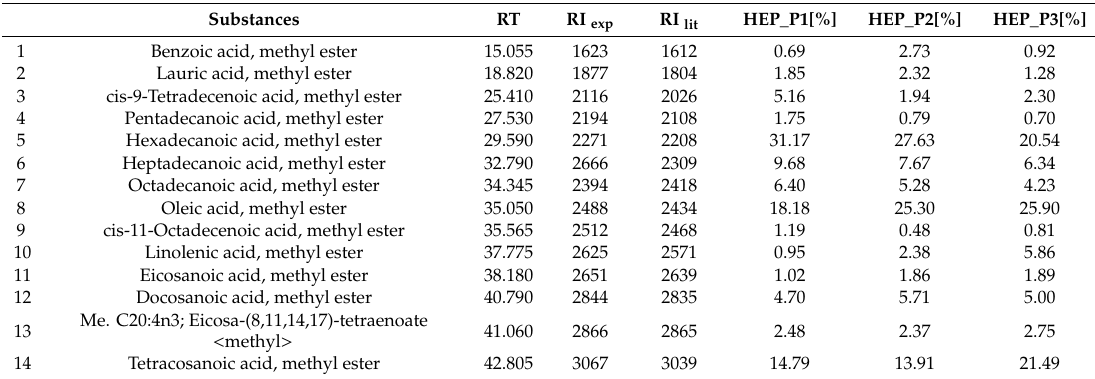
Table A4. Percentage of fatty acids in hexane extracts of propolis (HEP) from di ff erent regions of Poland: HEP_P1 —Podlasie (Hajnowka), HEP_P2 —Masovia (Ciechanow), HEP_P3 —West Pomerania Province